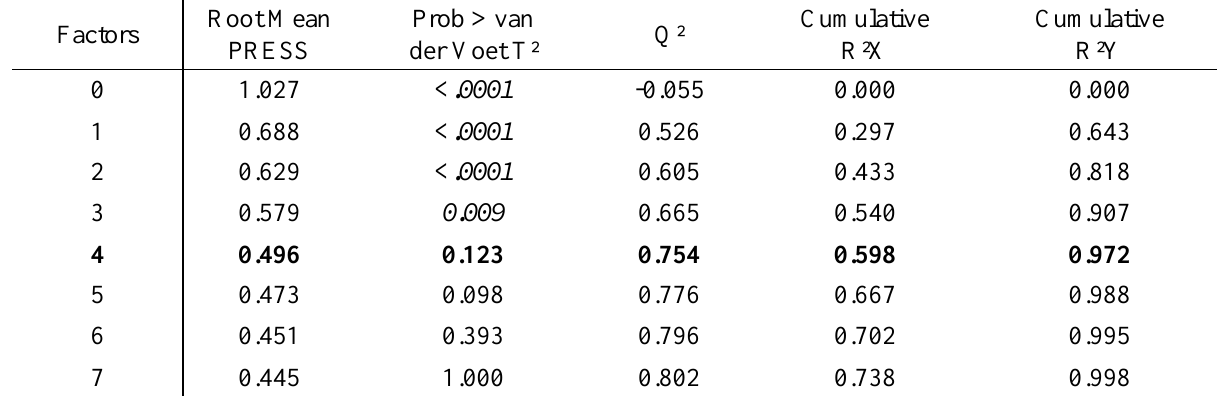
Table 2. Summary data for direct polarisation PLS models incorporating different depth intervals (0–40 cm, > 40 cm). The models predict the mass percent of PyC in a sample. Bold type identifies the model that is the focus of analysis. Italicised cells indicate significant (p < 0.05) differences in van der Voet T 2